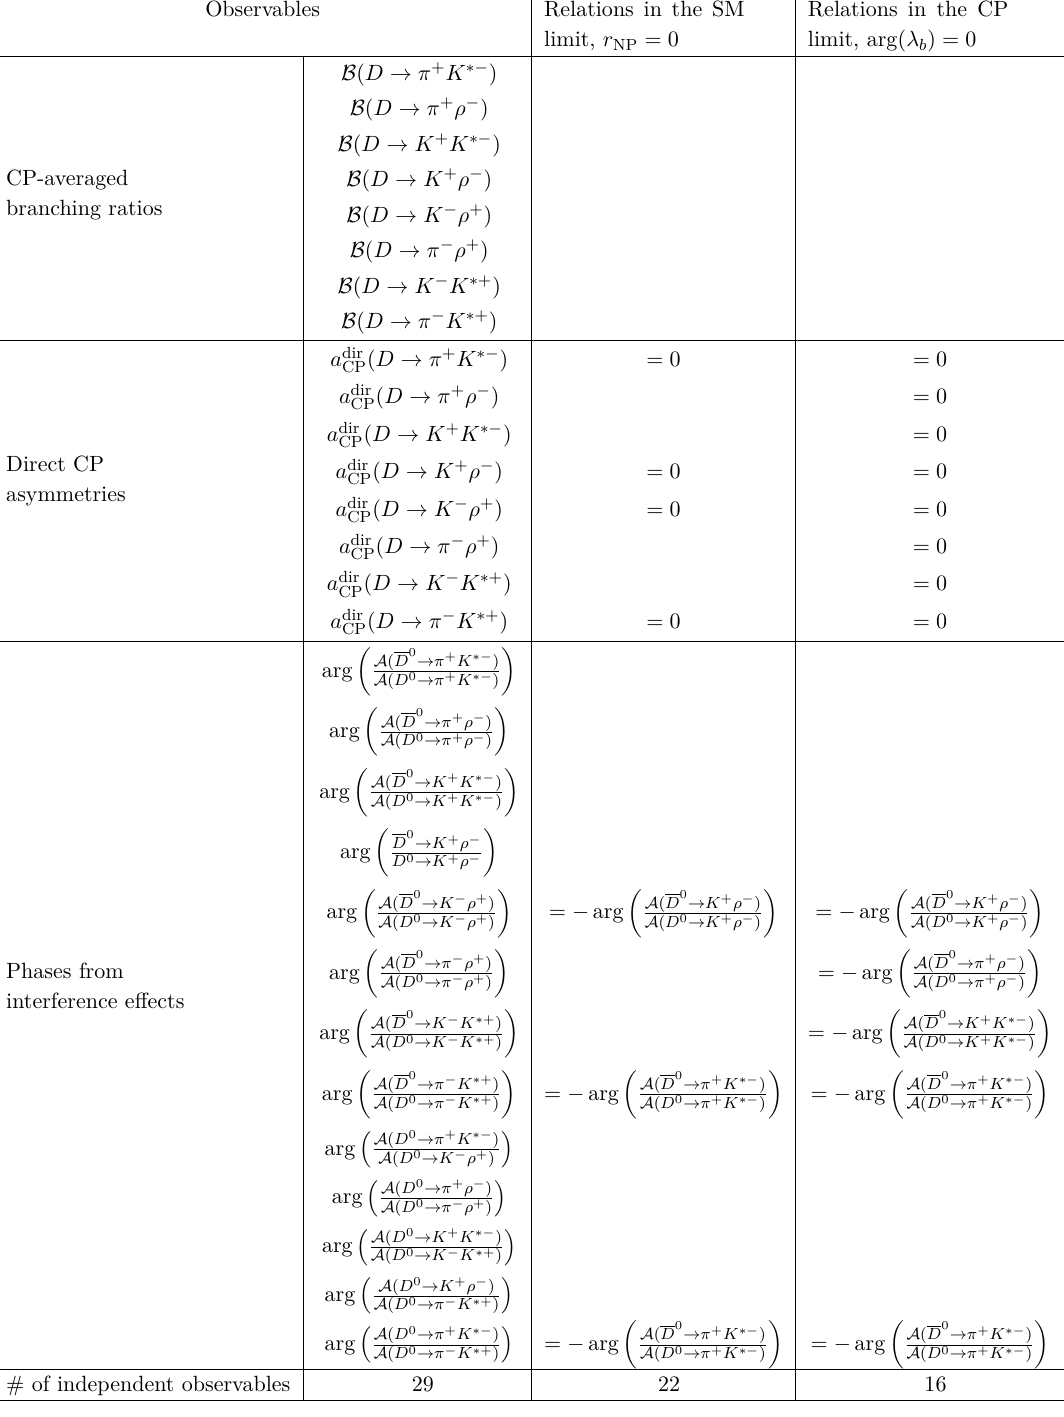
Table 3 . Available observables in the D → V P system, and relations between them in the SM limit and in the CP